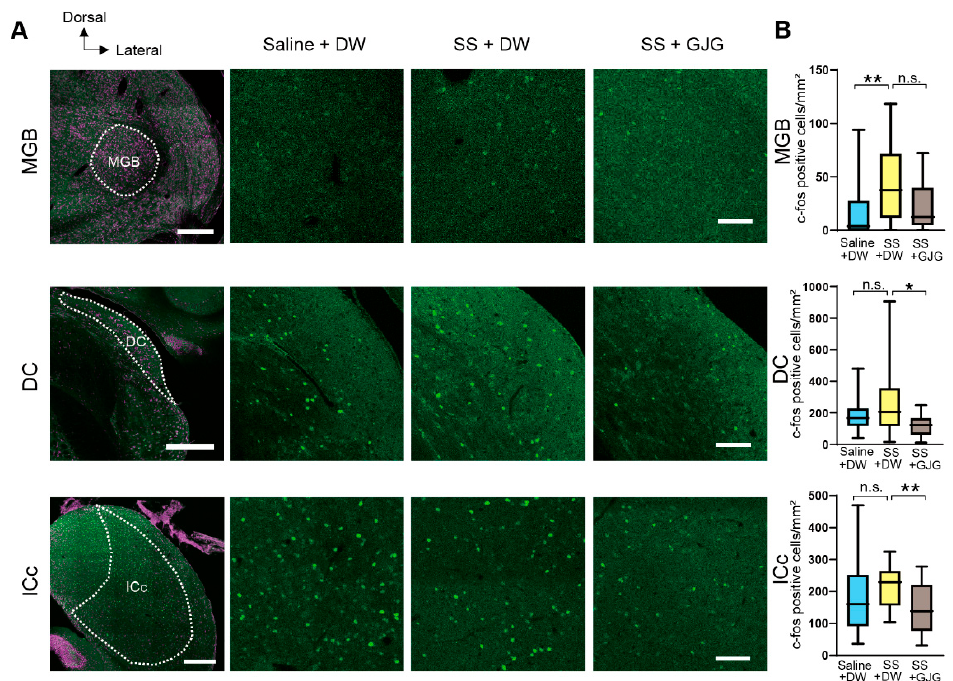
Figure 5. Effect of goshajinkigan (GJG) administration on c-Fos expression in the auditory thalamus and brainstem nuclei of salicylate-treated rats. ( A ) Fluorescent photomicrographs of the medial geniculate body (MGB), dorsal cochlear nucleus (DC), and central nucleus of the inferior colliculus (ICc). These areas were separated based on Nissl stainings (shown in magenta) in low magnification fluorescent photomicrographs (leftmost column). Green dots show c-Fos-expressing cells in the Saline + distilled water (DW) group (second column), sodium salicylate (SS) + DW group (third column), and SS + GJG group (rightmost column). Scale bars = 500 µm (leftmost column) and 100 µm (rightmost column). ( B ) Comparison of the numbers of c-Fos-expressing cells in Saline + DW, SS + DW, and SS + GJG groups. In the MGB, the number of c-Fos-expressing cells was significantly larger in the SS + DW group than in the Saline + DW group. In the DC and ICc, cell numbers in the SS + DW group were significantly higher than those in the SS + GJG group. Data are presented as median (interquartile range) and are analyzed using the Mann–Whitney U test, n = 6 in each group. Asterisks indicate a significant difference between groups (* p < 0.05; ** p < 0.01).